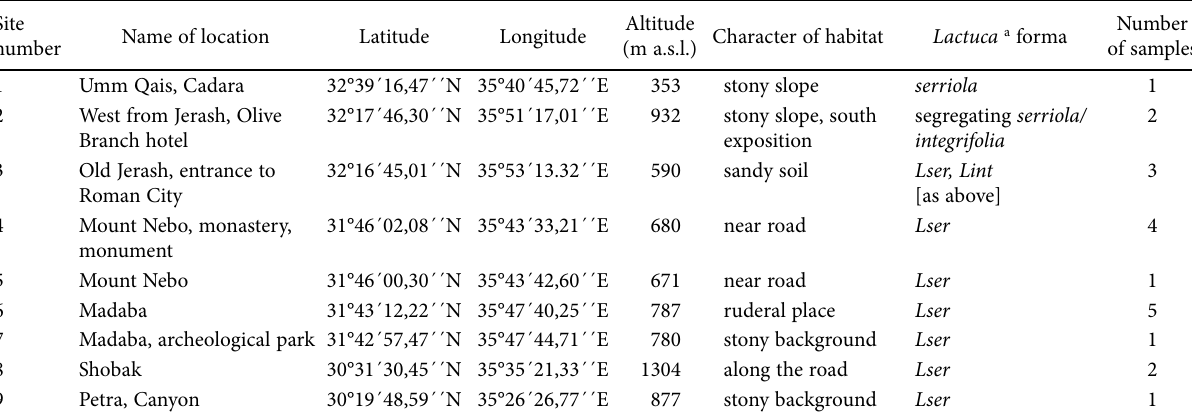
Table 1. List of monitoring sites with wild Lactuca species in Jordan in